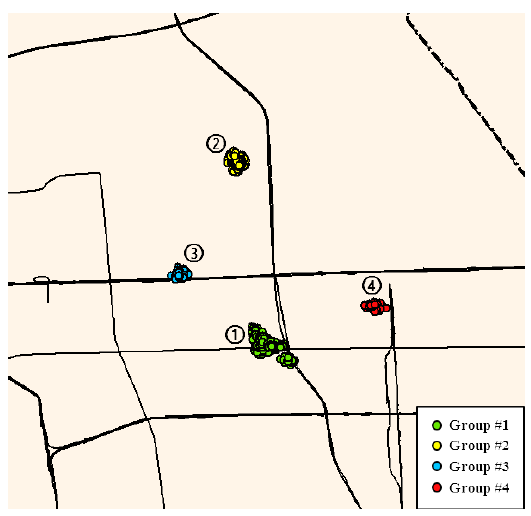
Figure 7. Aggregating individuals based on the similarity of their visits to their workplaces.